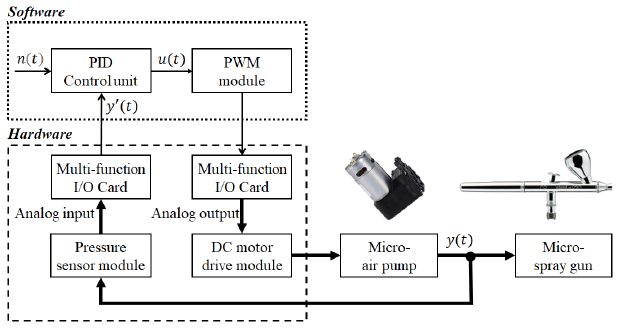
Figure 3. PID control test architecture of micro air pump.